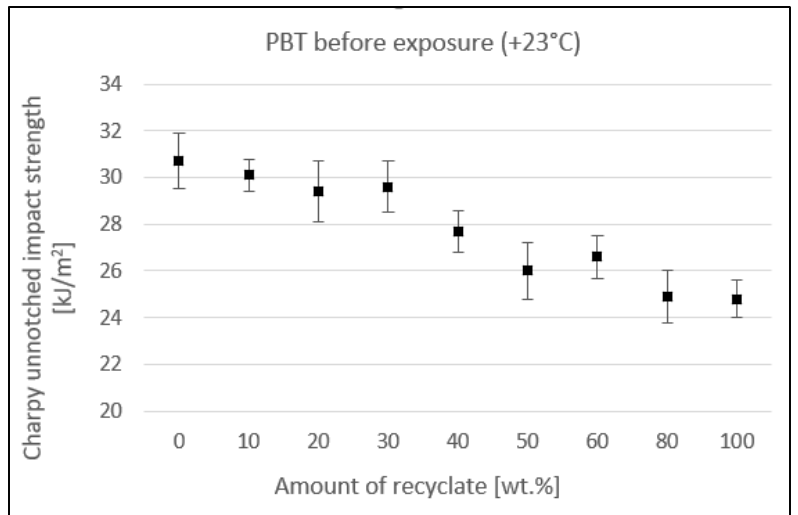
Figure 2. Dependence of the unnotched impact strength of PBT on the amount of recycled material before the samples were exposed to elevated temperature (+23 °C).